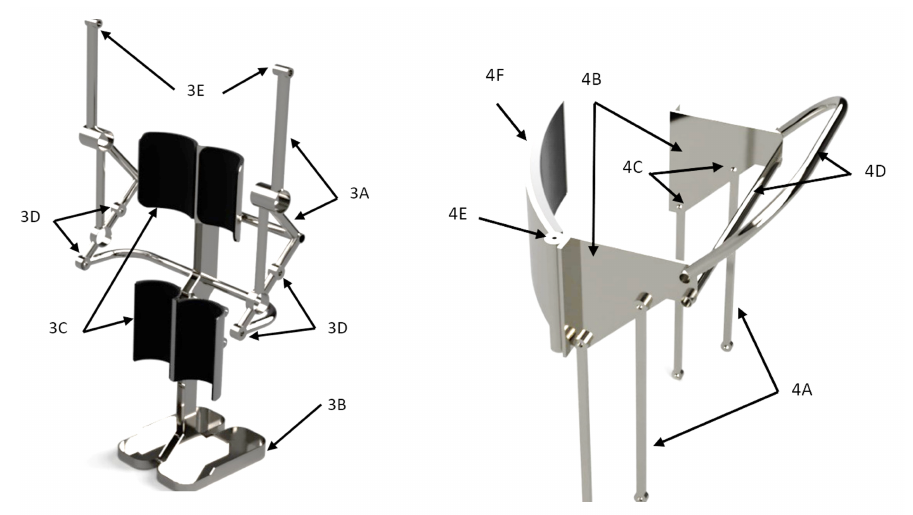
Figure 8. Model of the stabilizing mechanism. ( Left ) Coronal, ( Right )